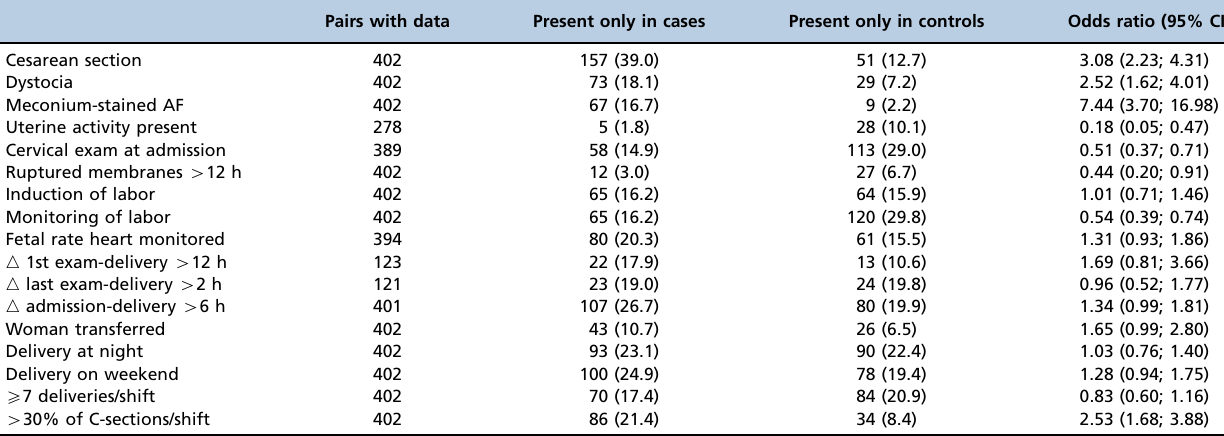
CI: confidence interval; AF: amniotic fluid; Woman transferred: pregnant woman transferred from another hospital.